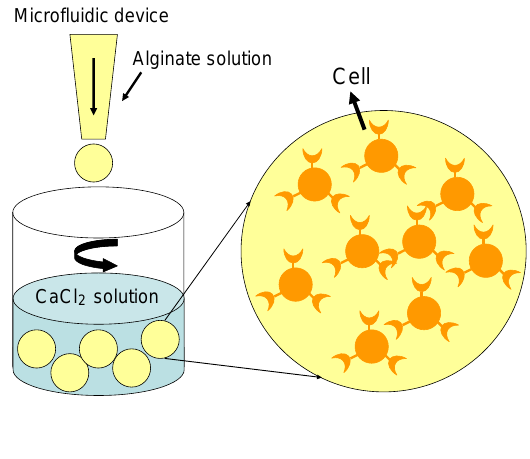
Figure 6. Illustration of the procedure for alginate gel-spheres in containing cells.